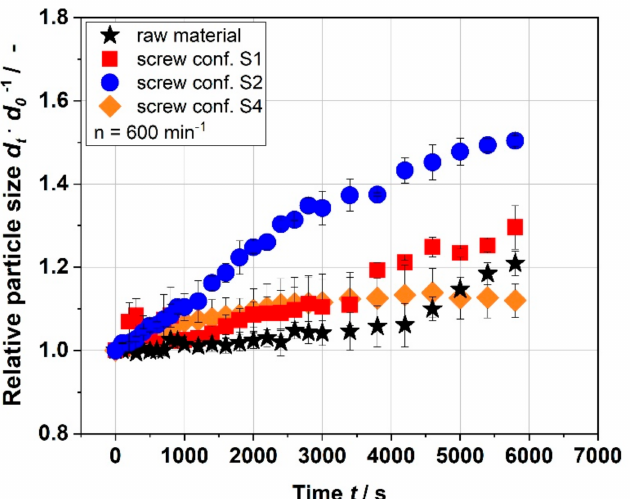
Figure 8. Change of size of raw material and various extruded samples by microscopic image analysis for a time period of almost 1 h 40 min. The relative particle size is the ratio between the area occupied by a particle at time t (A t ) and the area occupied by the particle at the initial time (A 0 ). S1: only transport elements, S2: two reverse elements, S4: two reverse elements and a kneading